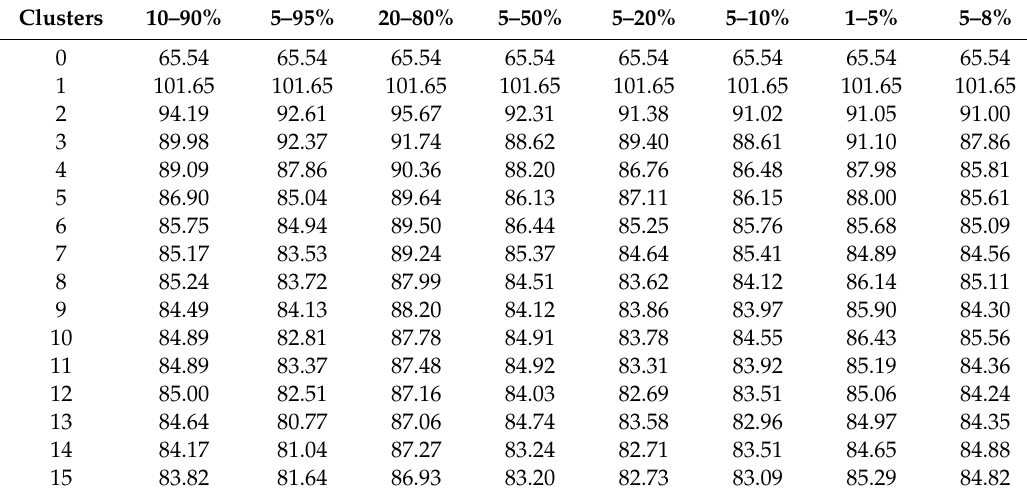
Table 2. Evolution of the mean di ff erence for the QSS between RTLR 5% and 1% quantile score, depending on the number of clusters and couples of quantiles